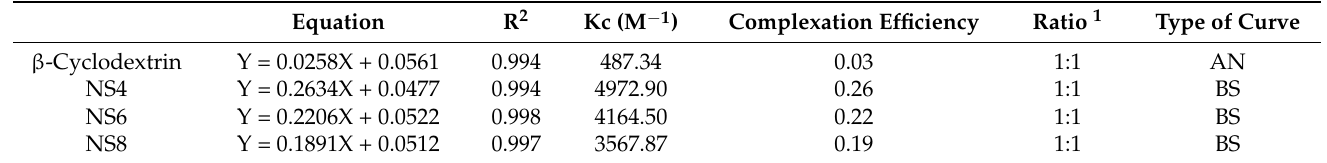
Figure 2. Phase solubility diagrams of: ( a ) curcumin- β -cyclodextrin complex; ( b ) curcumin-loaded nanosponges. Table 1 represents the determined parameters of the complex formation of curcumin with β -cyclodextrin and β -cyclodextrin-based nanosponges. These parameters are cal- culated according to the slope of the resultant initial linear part of the solubility phase diagram; all regression lines show a linear correlation (R 2 ≥ 0.994). Table 1. Regression line equation and coefficient, complexation constant (Kc), and complexation efficiency (CE) as obtained from the linear part of the phase solubility diagram.